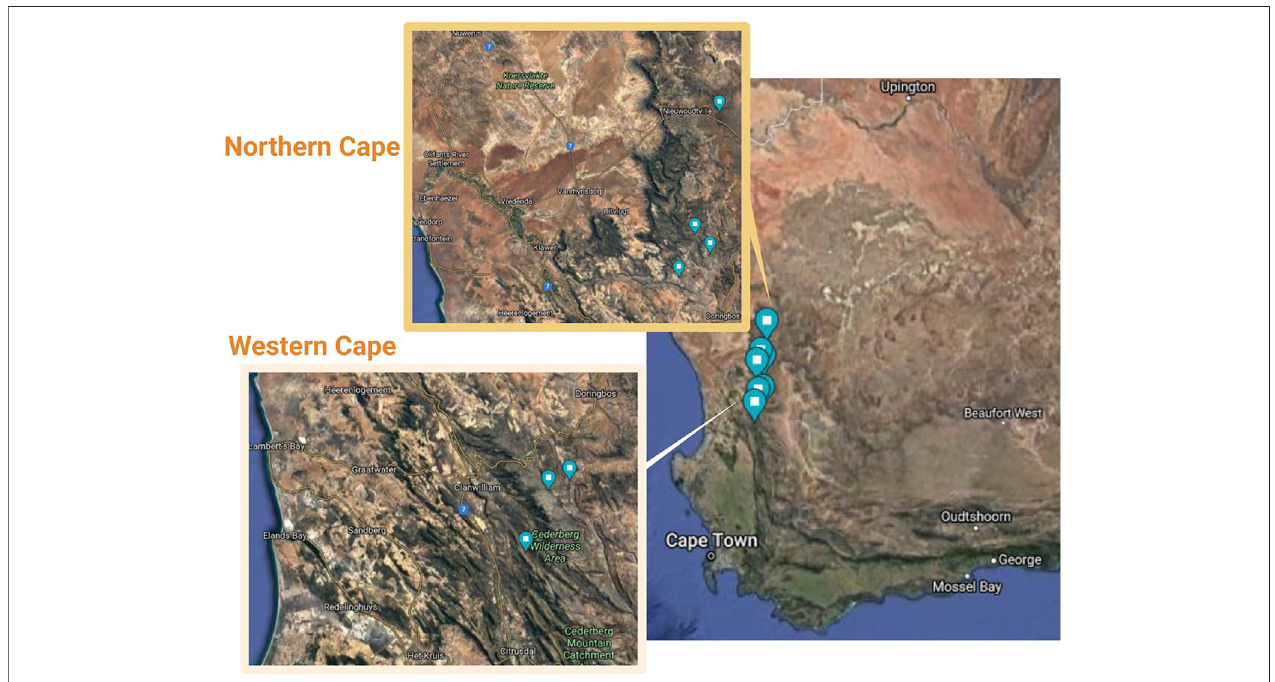
FIGURE 1 | Collection sites of wild-growing Aspalathus linearis in the Cederberg area of the Western Cape and Northern Cape of South Africa.